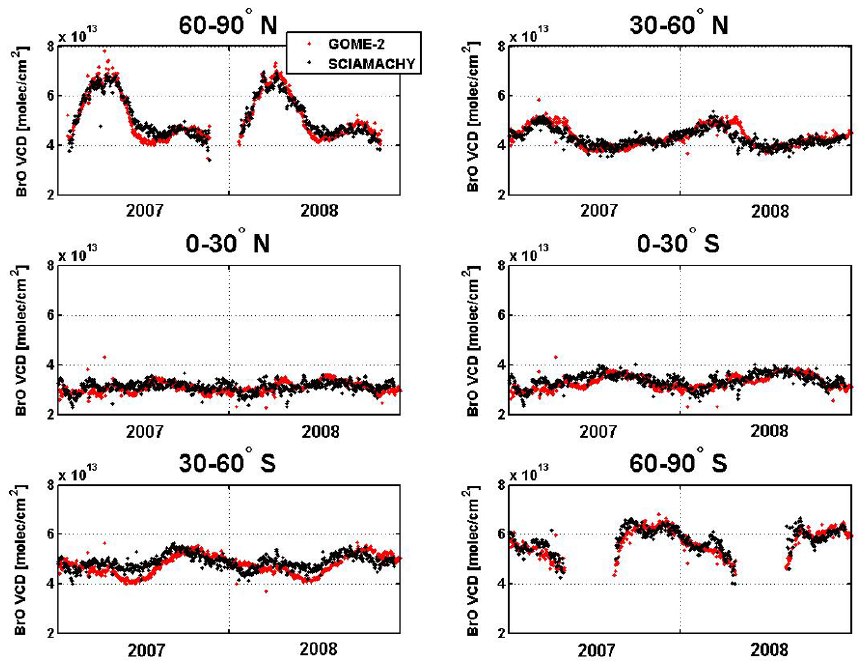
Fig. 5. Time-series of total BrO vertical columns from GOME-2 and SCIAMACHY nadir observations for different latitudinal bands (daily zonal averages). Only data corresponding to solar zenith angles lower than 80 ◦ are shown.